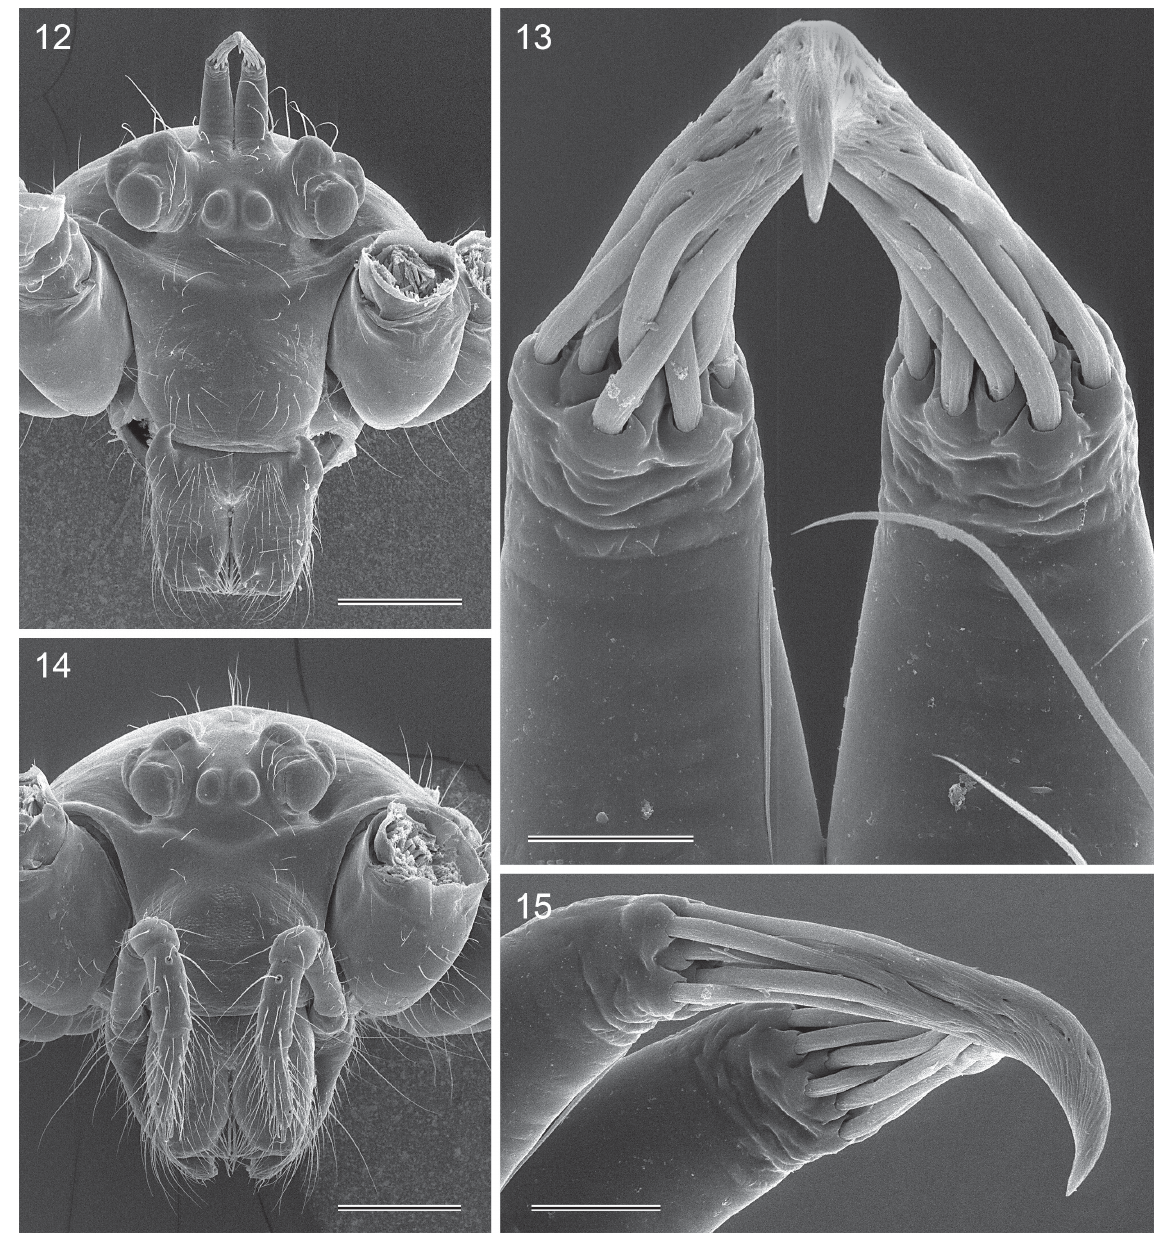
Figs 12–15. Pholcus olangapo Huber, sp. nov., ZFMK Ar 15497–98. 12 . Male prosoma, frontal view. 13, 15 . Male ocular horns with modified and ‘glued’ or ‘waxed’ hairs, frontal and lateral views. 14 . Female prosoma, frontal view. Scale lines: 12, 14 = 400 µm; 13 = 50 µm; 15 = 60